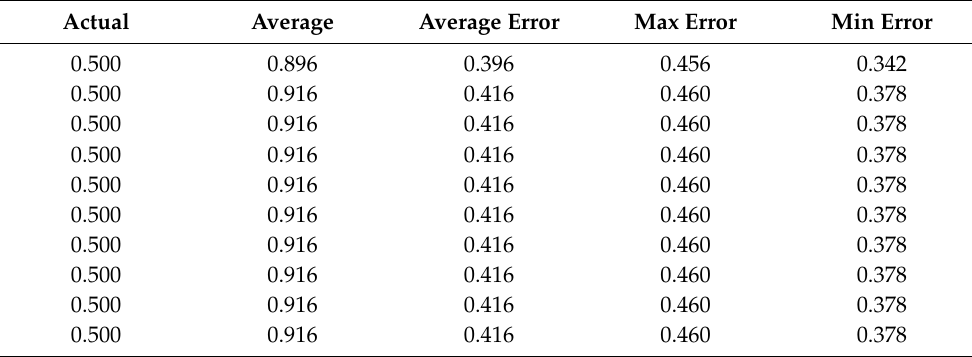
Table A174. Set 3, trials 11–20 data (all 0.5 PR